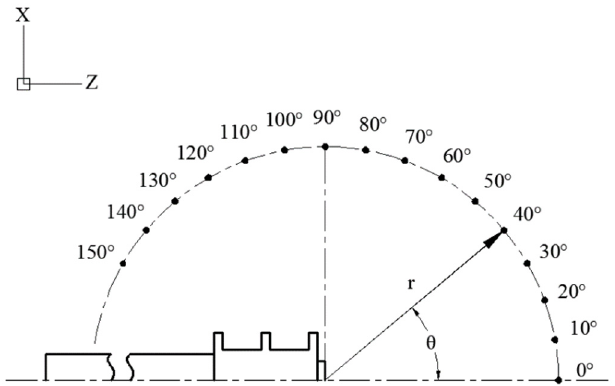
Figure 5. Flow chart of the CFD-CAA hybrid method.